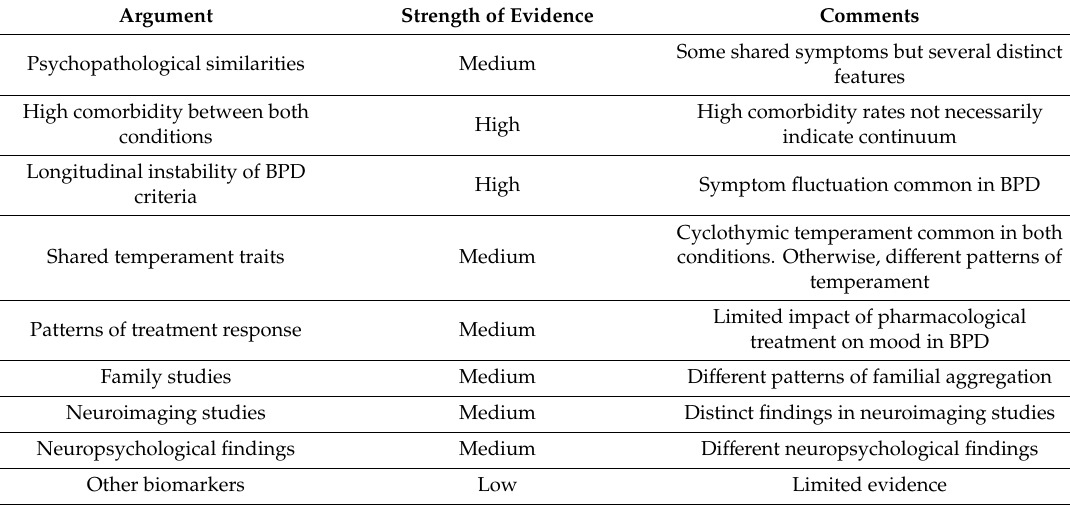
Table 1. Evidence supporting and opposing the existence of a continuum between BD and